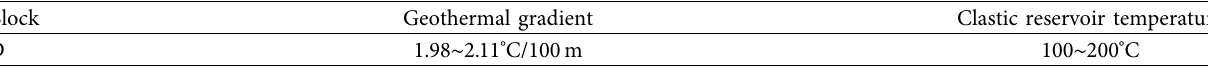
Table 1: Reservoir section temperature in the study area with green synthesis and metal oxide composites.